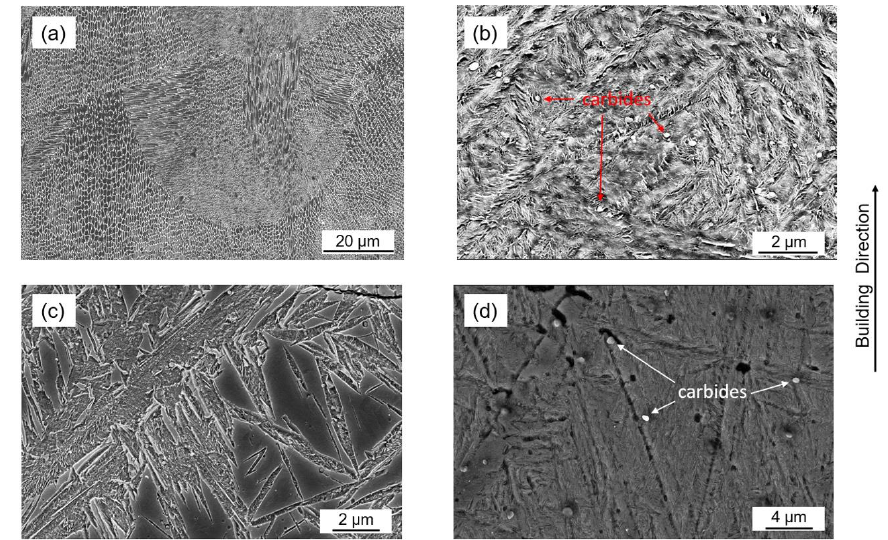
Figure 6. SEM images of microstructure. ( a ) as-built with 250 °C preheating; ( b ) conventional heat treatment; ( c ) HIP with quenching; ( d ) HIP with quenching and tempering. Elemental mapping revealed an inhomogeneous element distribution. Figure 7 shows the microstructure of the as-built sample with 250 °C preheating and correspond- ing EDS mappings. The fast solidification of the melting pool during the LPBF process led to the segregation of alloy elements. The cellular walls were enriched with carbon and carbides forming elements like Cr, Mo, and V. Figure 7. Backscattered-Electron ( BSE) micrograph of the as-built sample with 250 °C preheating temperature and corresponding elemental Energy Dispersive Spectroscopy (EDS) mapping. Figure 8 presents the result of the EBSD measurement of the sample produced at the preheating temperature of 250 °C. In the EBSD phase map (Figure 8a), a small amount of retained austenite remains among the martensitic dendrites. The white area was supposed to be the carbon enriched area, which cannot be indexed by EBSD measurement. A fine